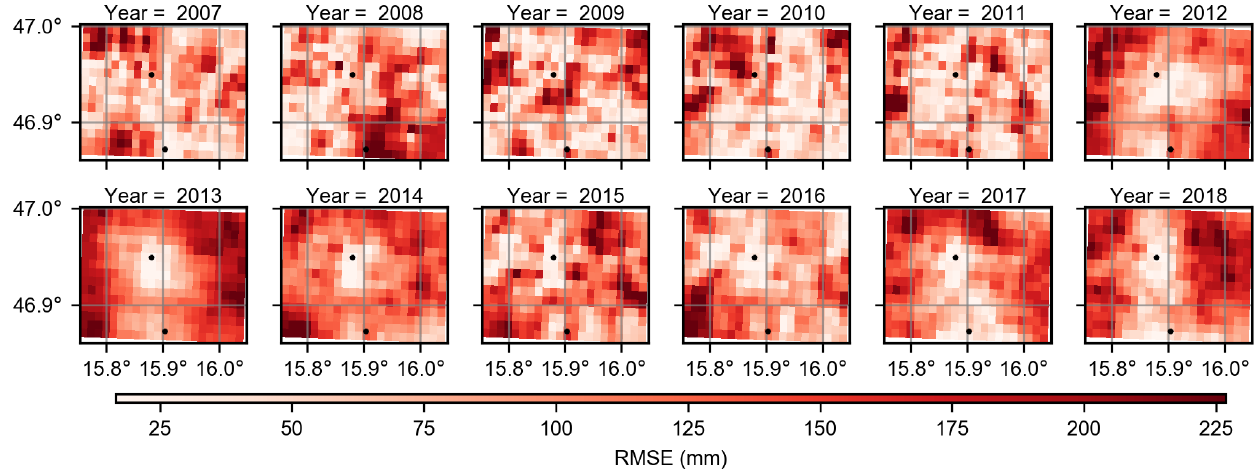
Figure B4. Annual RMSE in each pixel. The black circles indicate the two ZAMG stations in the study area.